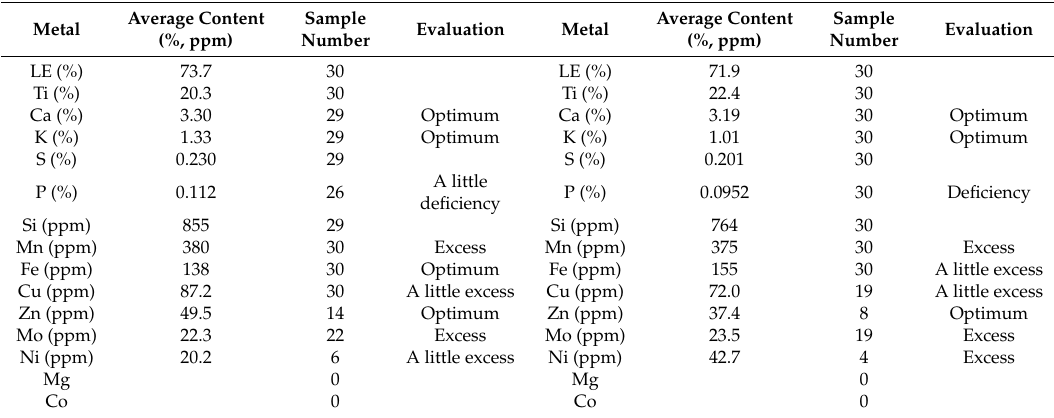
Table 4. Average element values of strong and weak values.